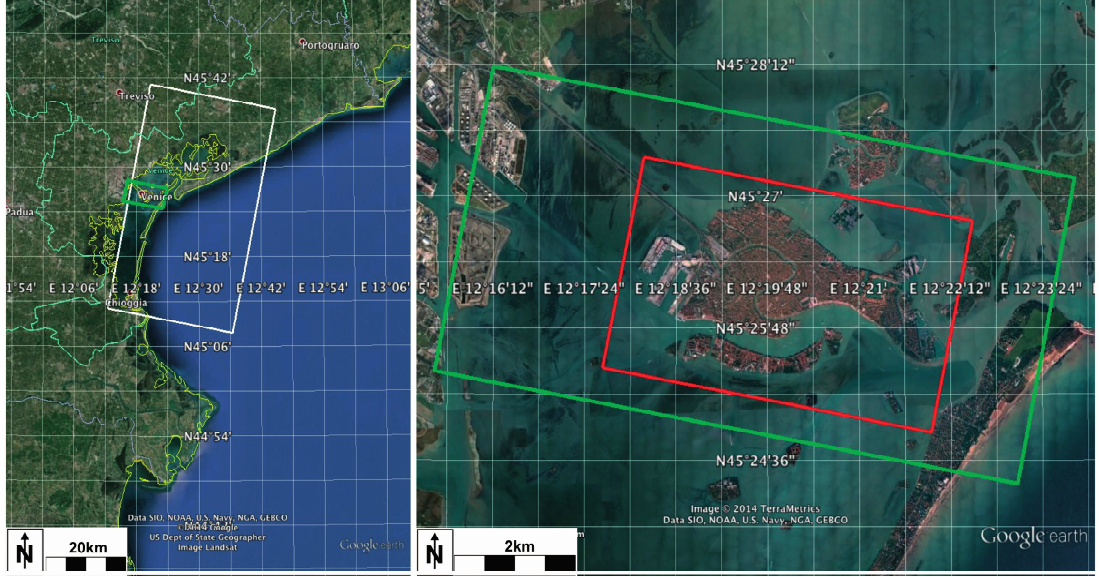
Figure 1. Location of the test site: white and green frames refer respectively to the stripmap and spotlight image ground coverage, while the red frame indicates the area of interest (AOI) selected for the experiment. Background optical image is from Google Earth.